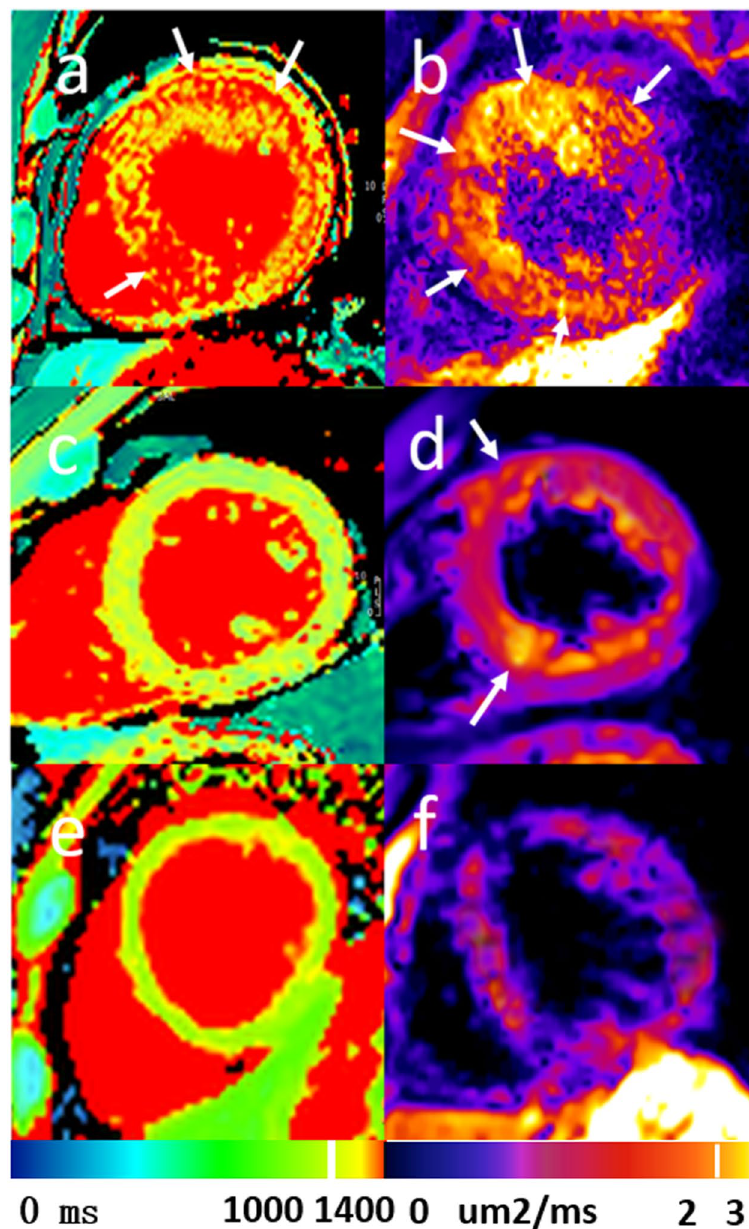
Figure 2. ( a , b ) Typical example of a 56-year-old male patient admitted with HTN LVH. Native T1 mapping showing diffuse fibrosis (white arrow) images ( a ), ADC mapping ( b ) showing diffuse fibrosis area, which was negative in the corresponding native T1 mapping (white arrow). ( c , d ) Typical example of a 55-year-old male patient admitted with HTN non-LVH. Native T1 mapping ( c ) showing negative fibrosis area and ADC mapping ( d ) showing focal fibrosis (white arrow), which was negative in native T1 mapping. ( d , e ) Typical example of a 36-year-old normal control. Native T1 mapping ( d ) and ADC mapping ( e